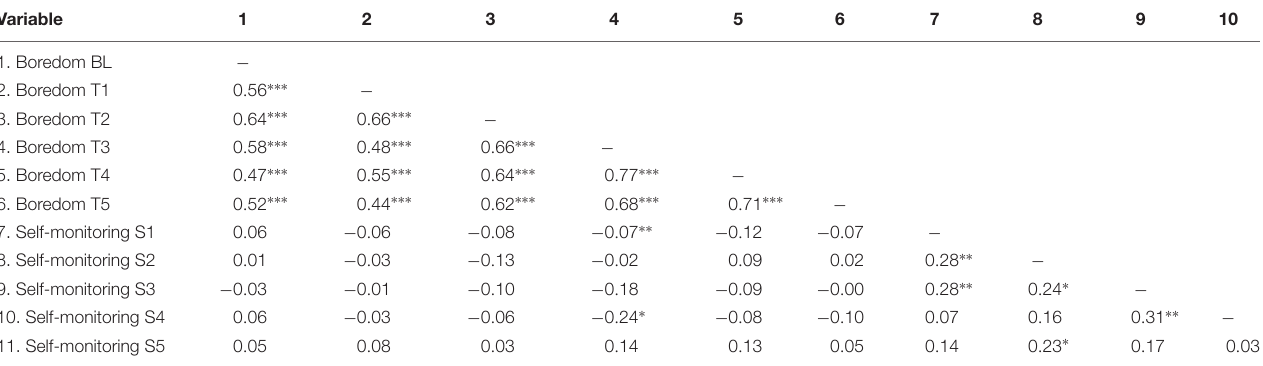
TABLE 4 | Pearson correlations between single measurement occasions of boredom and self-monitoring. Variable